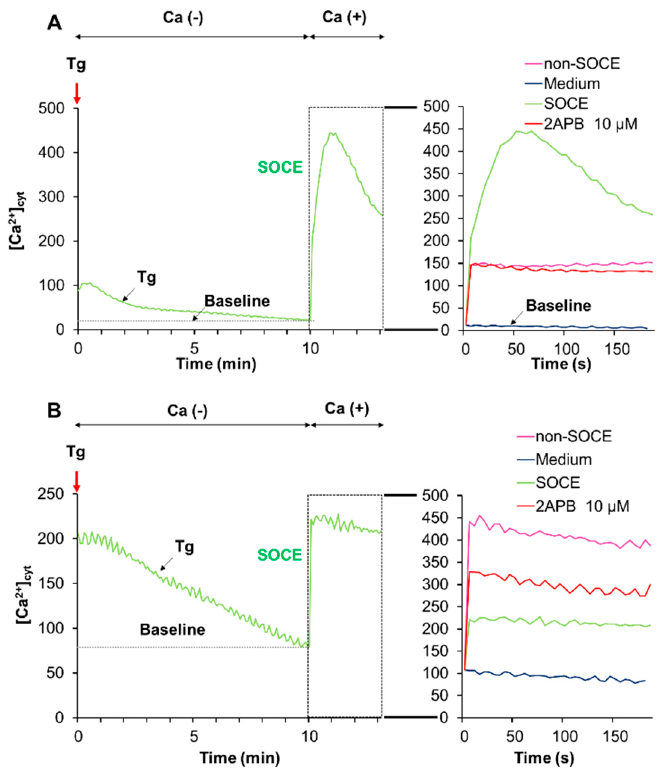
Figure 6. Acidification mitigates store-operated Ca 2+ entry (SOCE). Fluo4-AM-loaded A375 cells were suspended in a Ca 2+ -free HBSS supplemented with 1 mM EGTA at pH 7.4 ( A , C ) or pH 6.8 ( B , D ), added with thapsigargin (Tg, 2 μ M, red arrow) and incubated for 10 min to deplete intracellular Ca 2+ stores. Then, two mM Ca 2+ was added to the cells (SOCE). After the addition of Tg, the fluorescence was monitored with excitation and emission at 485 and 538 nm, respectively. For validating SOCE, the cells in the Ca 2+ -free buffer were treated as described above in the presence of 2-APB (10 μ M). For non-SOCE measurement, the cells in the Ca 2+ -free buffer were treated with the medium and then added with 2 mM Ca 2+ (non-SOCE). Note that at pH 7.4, a higher increase in [Ca 2+ ] cyt was seen in the SOCE trace compared to the non-SOCE trace, and this effect was entirely abolished by 2-APB. Meanwhile, no such effect was seen at pH 6.8.